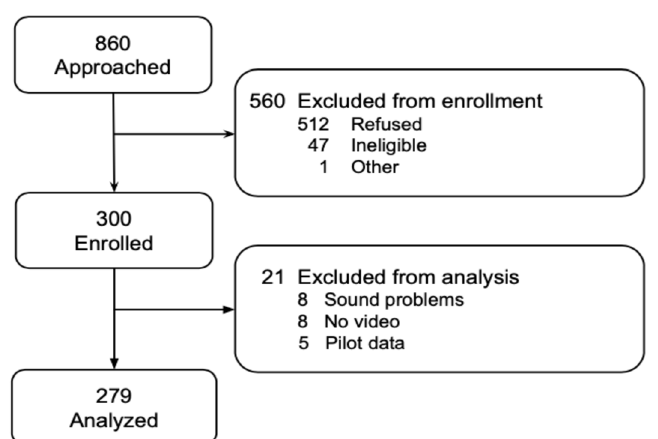
Figure 1. Flow diagram of patient selection process for study comparing patient and physician pain scoring at emergency department